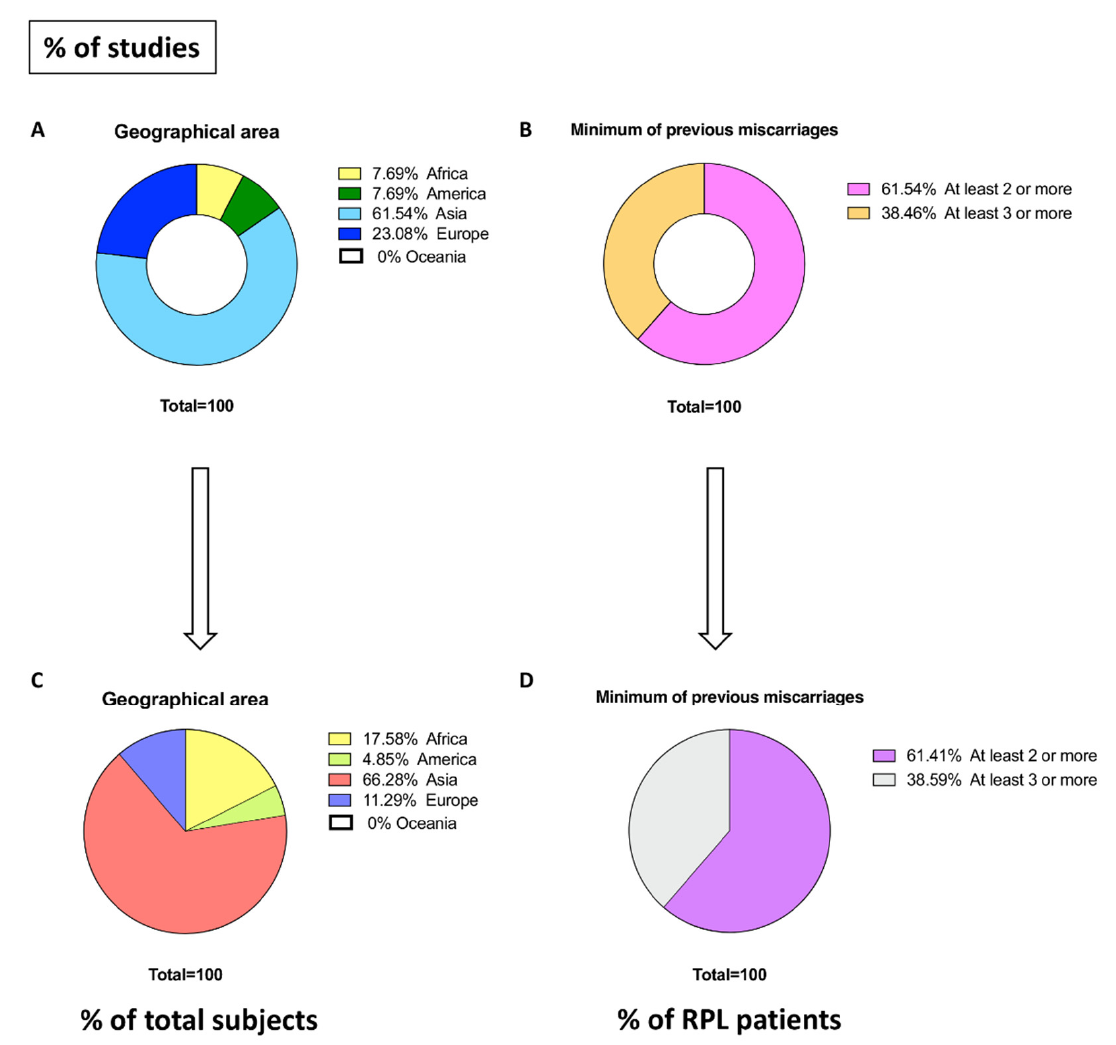
Figure 2. Preliminary analysis of the included studies. Charts on the geographical area distribution and number of previous miscarriages of the included studies. Charts describe: ( A ) the geographical area of included studies subdividing them into five macro areas; ( B ) the percentage of included studies reporting the minimum of previous miscarriages; ( C ) the percentage of subjects for every continent; ( D ) the percentage of RPL patients based on previous miscarriages.